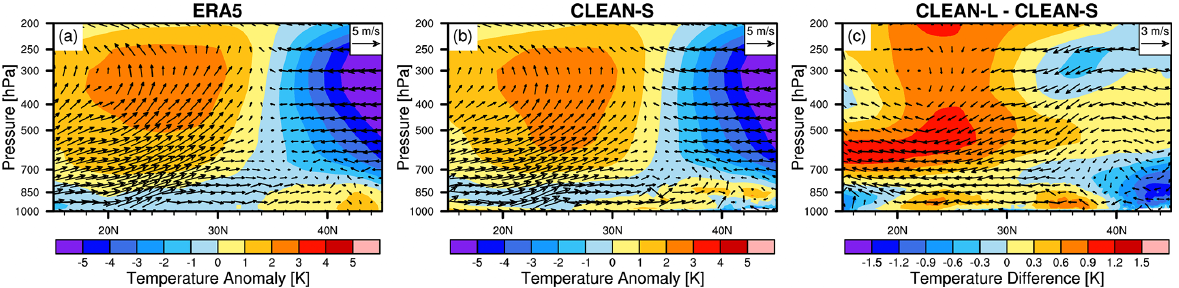
Figure 4. (a, b) The cross section of meridional temperature anomalies and wind averaged for 105 and 122 ◦ E from the ERA5 reanalysis and the CLEAN-S simulation during June to July, and (c) the difference of temperature (not meridional temperature anomalies) between CLEAN-L and CLEAN-S. The meridional temperature anomalies are calculated by subtracting the mean temperature in this latitude range at each pressure level.